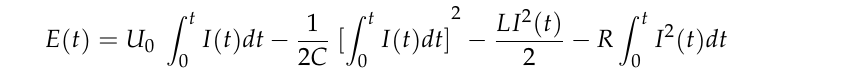
Table 1. Operating Parameters for Obtaining Al Powders.